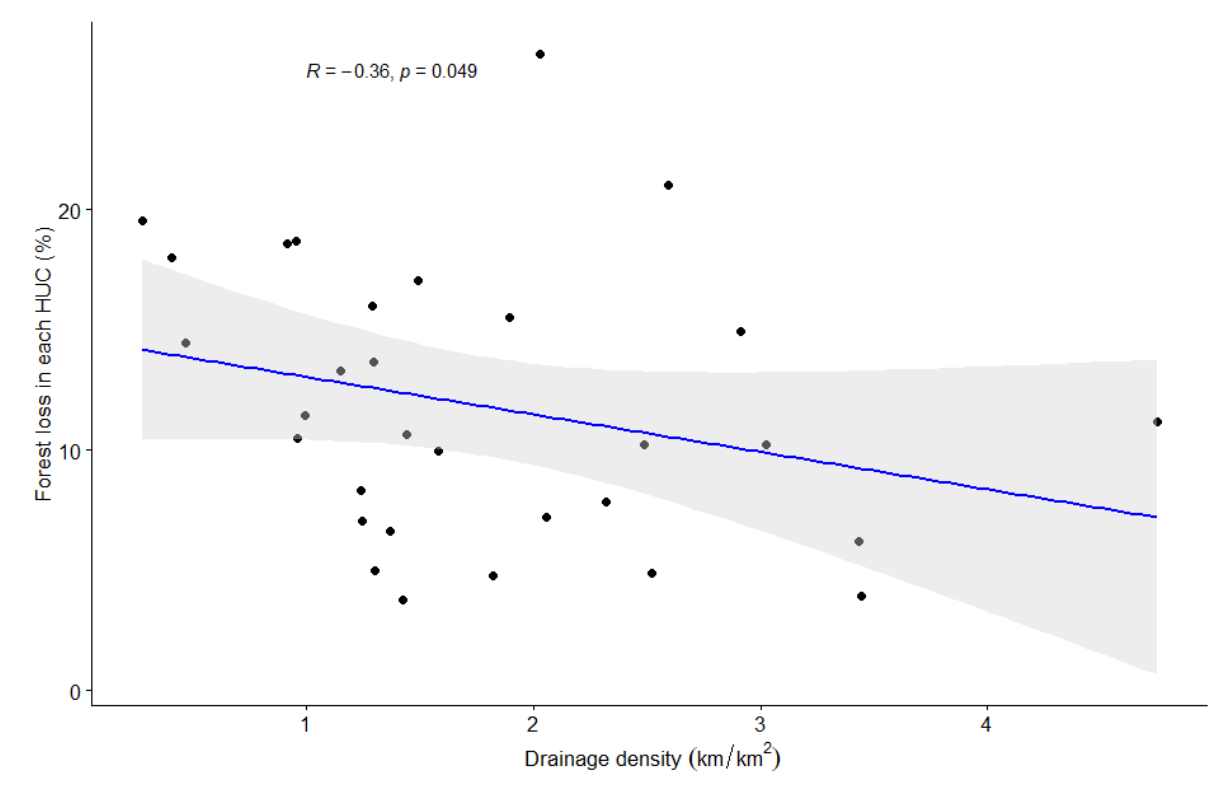
Figure 4. Spearman correlation of percentage of forest loss per HUC (%) and drainage density.